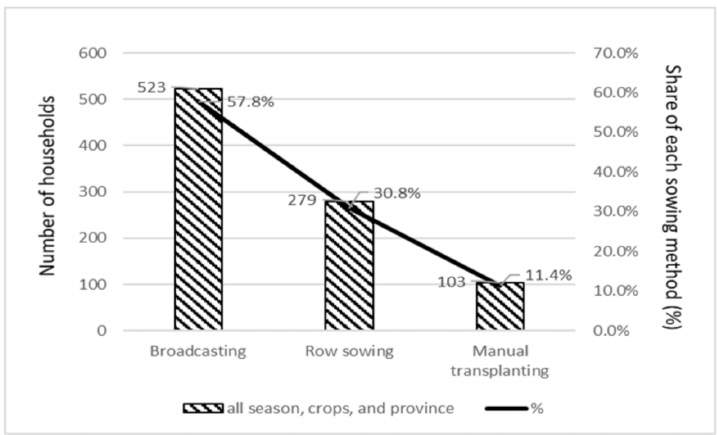
Figure 14. Share of each sowing method; accumulated data from Tables 5–7; all season, cropping pattern, and province data were accumulated. Source: Authors’